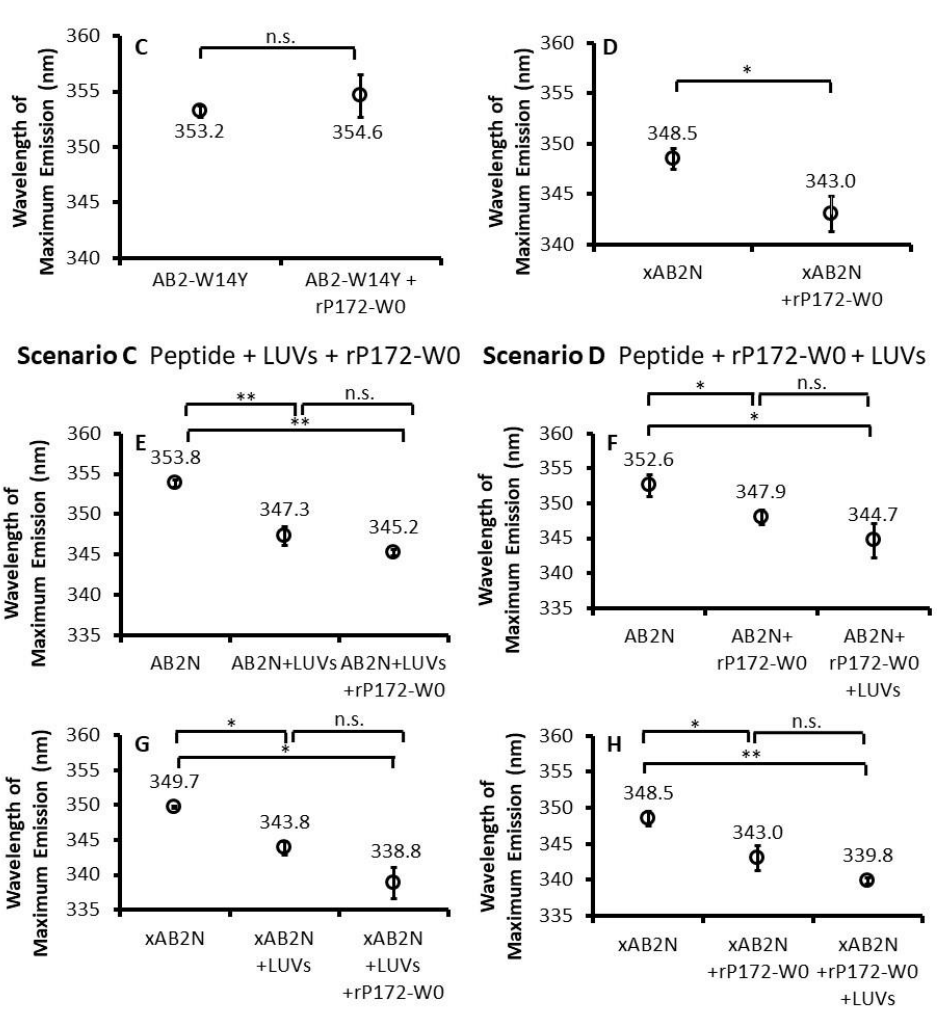
Figure 8. Wavelengths of maximum intrinsic tryptophan fluorescence emission from 8 µM ( A ) AB2, ( B ) AB2N, ( C ) AB2-W14Y, and ( D ) xAB2N before and after addition of 40 µM rP172-W0. Wavelengths of maximum emission from 8 µM AB2N with ( E ) first 240 µM LUVs added in, then 40 µM rP172-W0, as in Scenario C in Figure 5, and with ( F ) first 40 µM rP172-W0 added in, then 240 µM LUVs, as in Scenario D in Figure 5. Wavelengths of maximum emission from 8 µM xAB2N with ( G ) first 240 µM LUVs added in, then 40 µM rP172-W0, as in Scenario C in Figure 5, and with ( H ) first 40 µM rP172-W0 added in, then 240 µM LUVs, as in Scenario D in Figure 5. Representative spectra for each condition shown in Figure S5. One- tailed Student’s t -test; n = 3; ** p < 0.01; * p < 0.05; n.s., not significant. Error bars represent standard errors of the mean.